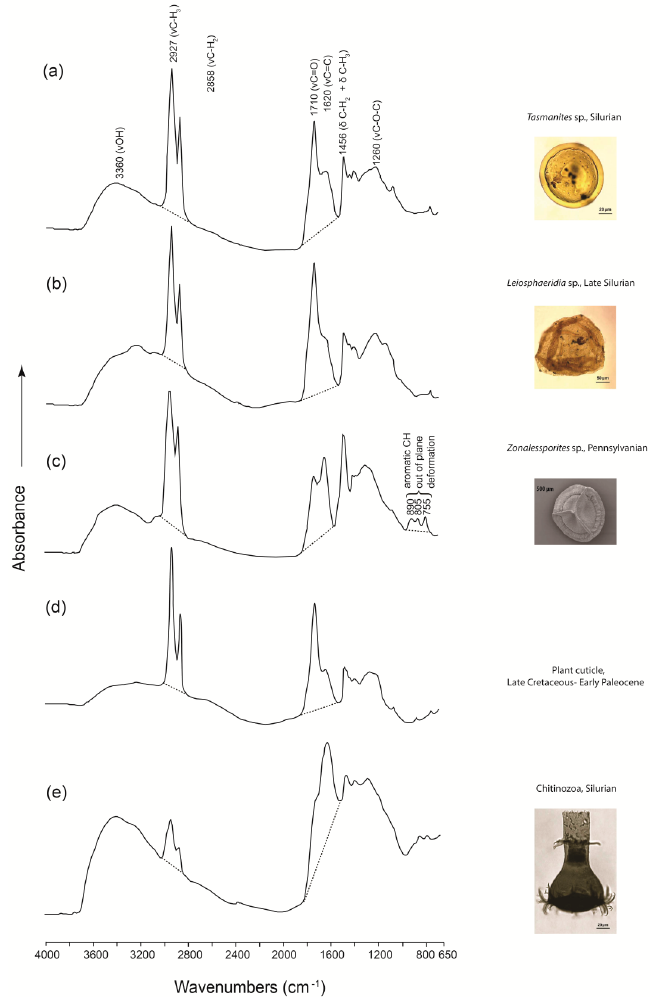
Figure 10. Left : Micro-FTIR spectra of prasinophycean algae ( a ) Tasmanites sp. from the Silurian, Oklahoma (USA) and ( b ) Leiosphaeridia sp. from the Late Silurian, Hazro area (Turkey); ( c ) a megaspore Zonalessporites sp. from the Pennsylvanian, Saarland (Germany); ( d ) a plant cuticle from the Late Cretaceous-Early Paleocene (western Germany); and ( e ) zoomorph Chitinozoa from the Silurian, Gotland (Sweden). Dashed lines indicate the linear baselines applied to the spectra. Right : Photomicrography of corresponding microfossils. Modified after figures 1–5 in Dutta et al. [139] with copyright permission from Elsevier.